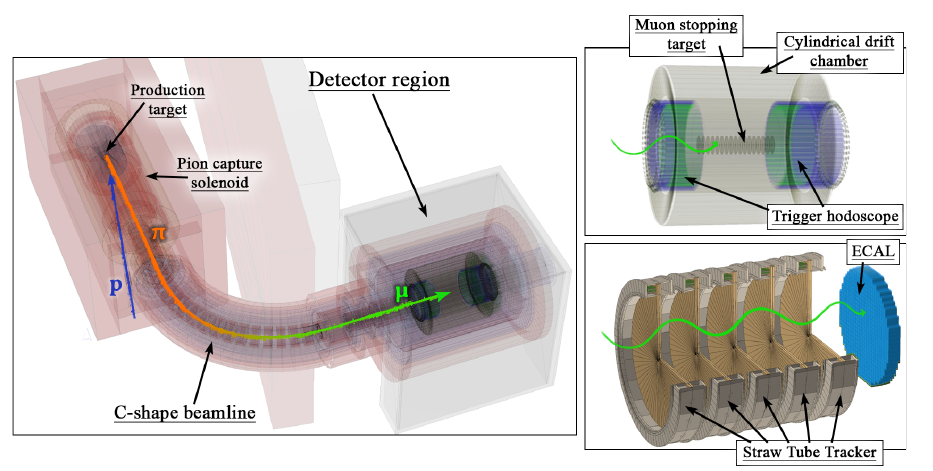
Figure 1. Left: Outline of the COMET Phase-I layout. For the detector region, two di ff erent configu- rations will be utilized. CyDet configuration ( top-right ); used to search for µ − e conversion. StrECAL configuration ( bottom-right ); used to measure the beam profile and prototype Phase-II